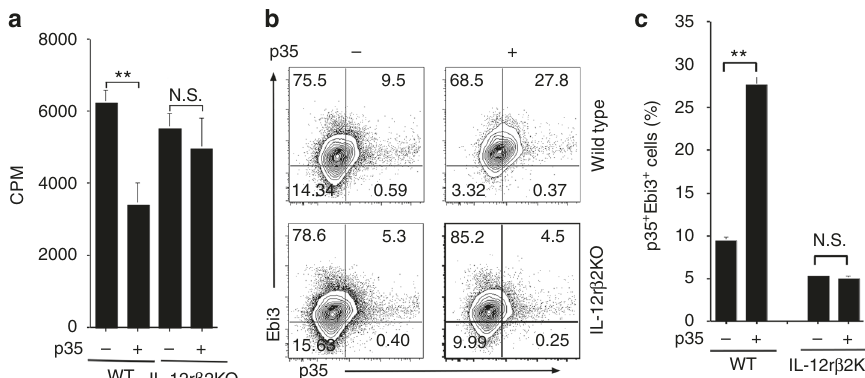
Fig. 7 Immunosuppressive effects of p35 require IL-12R β 2. a CD19 + B cells from the spleen of WT or IL-12R β 2KO mice were activated with LPS for 3 days in the presence or absence of p35 and proliferative capacity of the cells was assessed by [ 3 H]-thymidine incorporation assay. b , c CD19 + B cells were activated with LPS in the absence or presence of p35 and analyzed by the intracellular cytokine-staining assay. The numbers in the quadrants indicate the percentages of IL-35-expressing B cells. Results represent at least three independent experiments and were analyzed using Student ’ s t -test (two-tailed). Data are mean ± SEM (* P < 0.05; ** P < 0.01; *** P < 0.001; **** P <